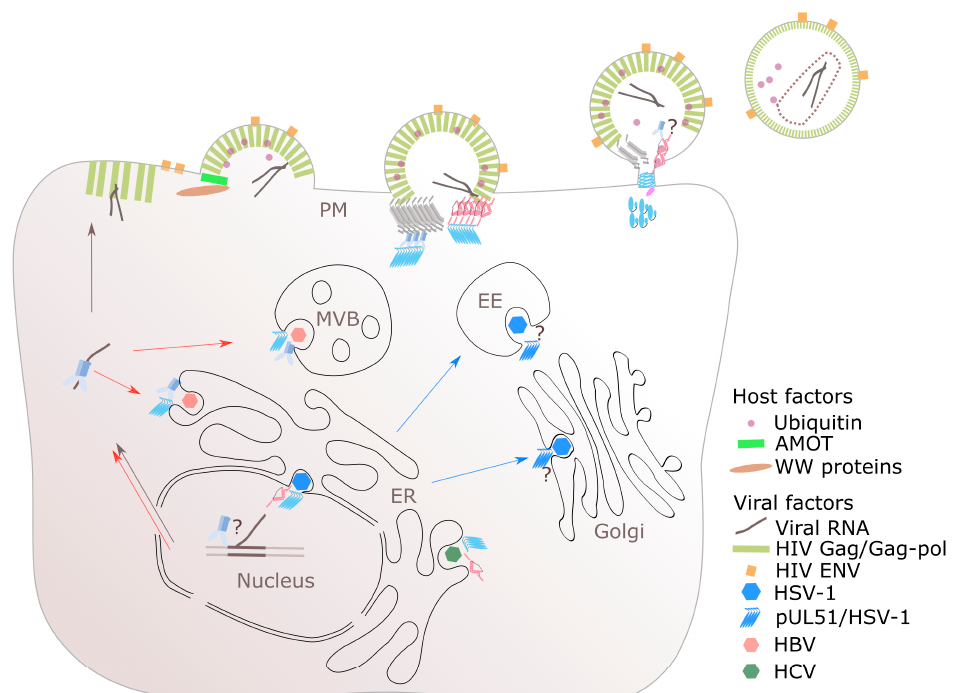
Figure 2. Multifaceted roles of ESCRT in the enveloped virus life cycles. The extracellular virus budding at the plasma membrane (PM) is exemplified with a late assembly and budding event of HIV. HIV, and other enveloped viruses, e.g., filovirus, rhabdovirus, and arenavirus (not shown), also utilises ubiquitination in gaining access to the ESCRT system for virus export. HSV-1 is unique as two steps of envelopments occur with the requirement of ALIX (ALG2-interacting protein X) and ESCRT-III for the nuclear or primary envelopment while a unique viral encoded ESCRT-III-like protein pUL51 is thought to be involved in membrane constriction for the secondary envelopment. ESCRT-II is involved in ribonucleoprotein trafficking for both HIV and HBV. The color scheme is the same as those in Figure 1 unless stated otherwise. Question marks denote the possibility of the involvement of ESCRT or other factors at various stages of virus life cycles. AMOT: angiomotin. ER: endoplasmic reticulum. EE: early endosome. MVB: multivesicular